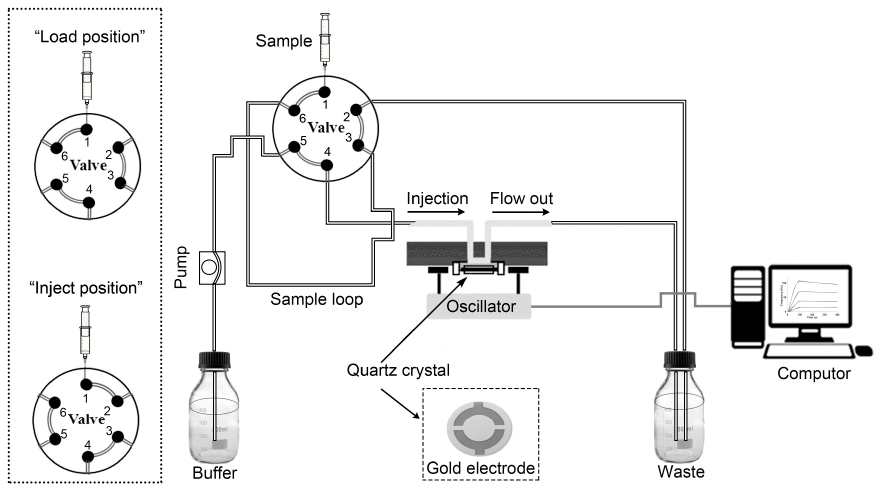
Figure 1. The flow-through system of the Attana QCM biosensor instrument.